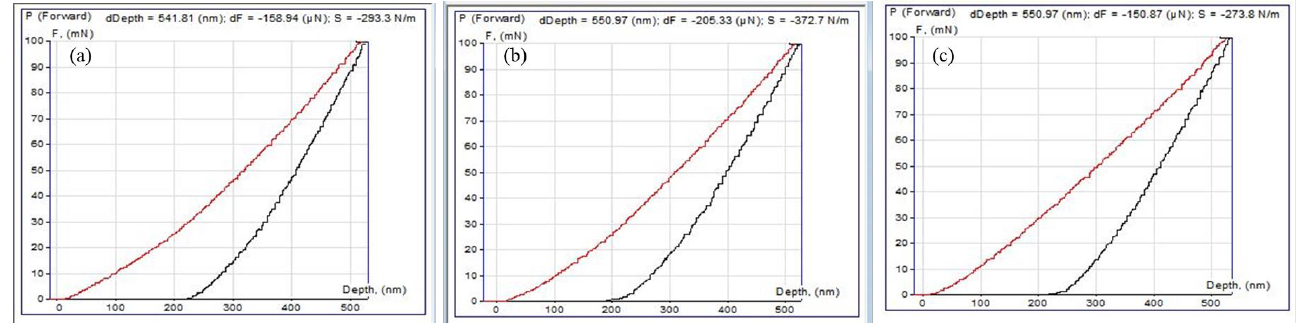
Figure 5. Load – displacement curves of the surface of multilayer gradient coatings: (a) three-layer; (b) five-layer and (c) Figure 5. Load–displacement curves of the surface of multilayer gradient coatings: ( a ) three-layer; ( b ) five-layer and six-layer. ( c ) six-layer.